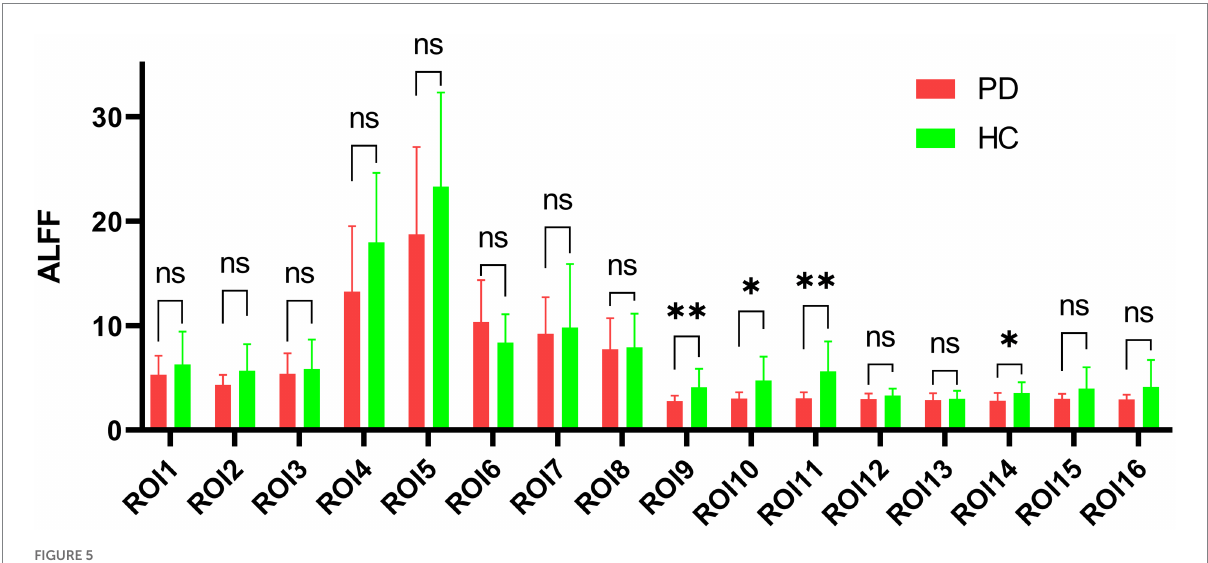
FIGURE 5 Amplitude comparison diagram of low-frequency fluctuation. ROI: region of interest, ALFF: amplitude of low-frequency fluctuations, PD: Parkinson’s disease group, HC: normal control group, ns: no significance, * p < 0.05, ** p < 0.01.